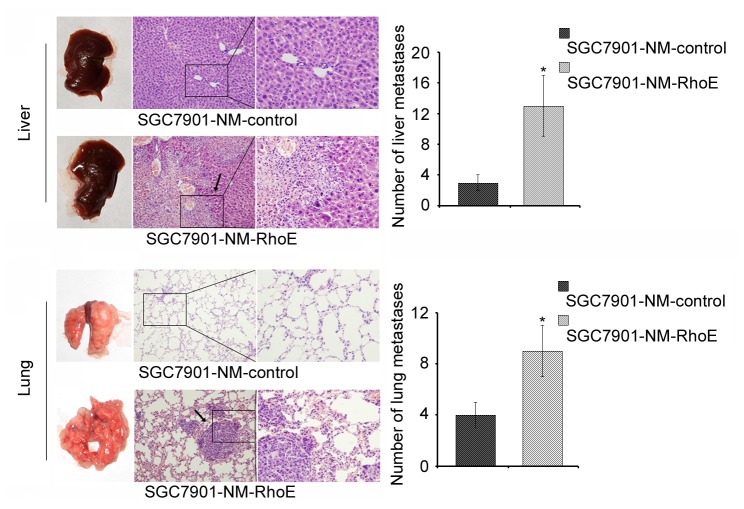
RhoE promotes the metastatic ability of gastric cancer cells in
vivo. H and E staining of both the lungs and livers were assessed from mice that had received intravenous tail injections of SGC7901-NM-RhoE and control cells respectively. Metastatic loci were identified and marked by arrows. The number of metastatic loci in the liver and lung were also counted (middle). *P <0.05.